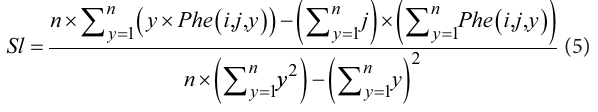
and Supplementary Figure S2B), but EOS EVI (mean 283.26 days) was later than EOS CSIF (mean 281.76 days) and EOS GOSIF (281.48 days) (Figure 3H and Supplementary Figure S2H). The croplands’ SOS was later than natural vegetation and GSL CSIF (or GSL GOSIF ) was also markedly shorter than natural vegetation for croplands (Figure 3C and Supplementary Figure S2C), but GSL EVI did not perform clearly (Figure 3F). In terms of the length of GSL, from longest to shortest growing period were GSL EVI (185.62 days), GSL GOSIF (158.81 days), and GSL CSIF (151.65 days) (Figure 3I and Supplementary Figure S2I). Overall, SOS EVI spanned about 2 months. EOS CSIF and EOS GOSIF were shorter (about 1 month), but EOS EVI spanned 2.5 months. GSL CSIF and GSL GOSIF had an 80-day spanned. GSL EVI spanned 100 days. The results showed that the length of the greenness phenology growth period represented by EVI was greater than that characterized by SIF for photosynthetic phenology.